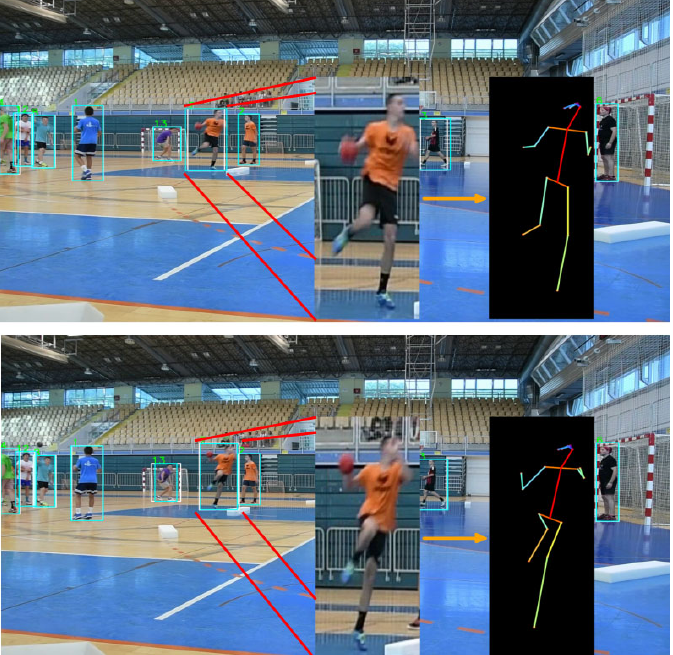
Figure 10. Two frames of a tracked player executing a jump shop where poses are estimated and performed necessary transformation. Blue bounding boxes visualize the detectors’ outputs,